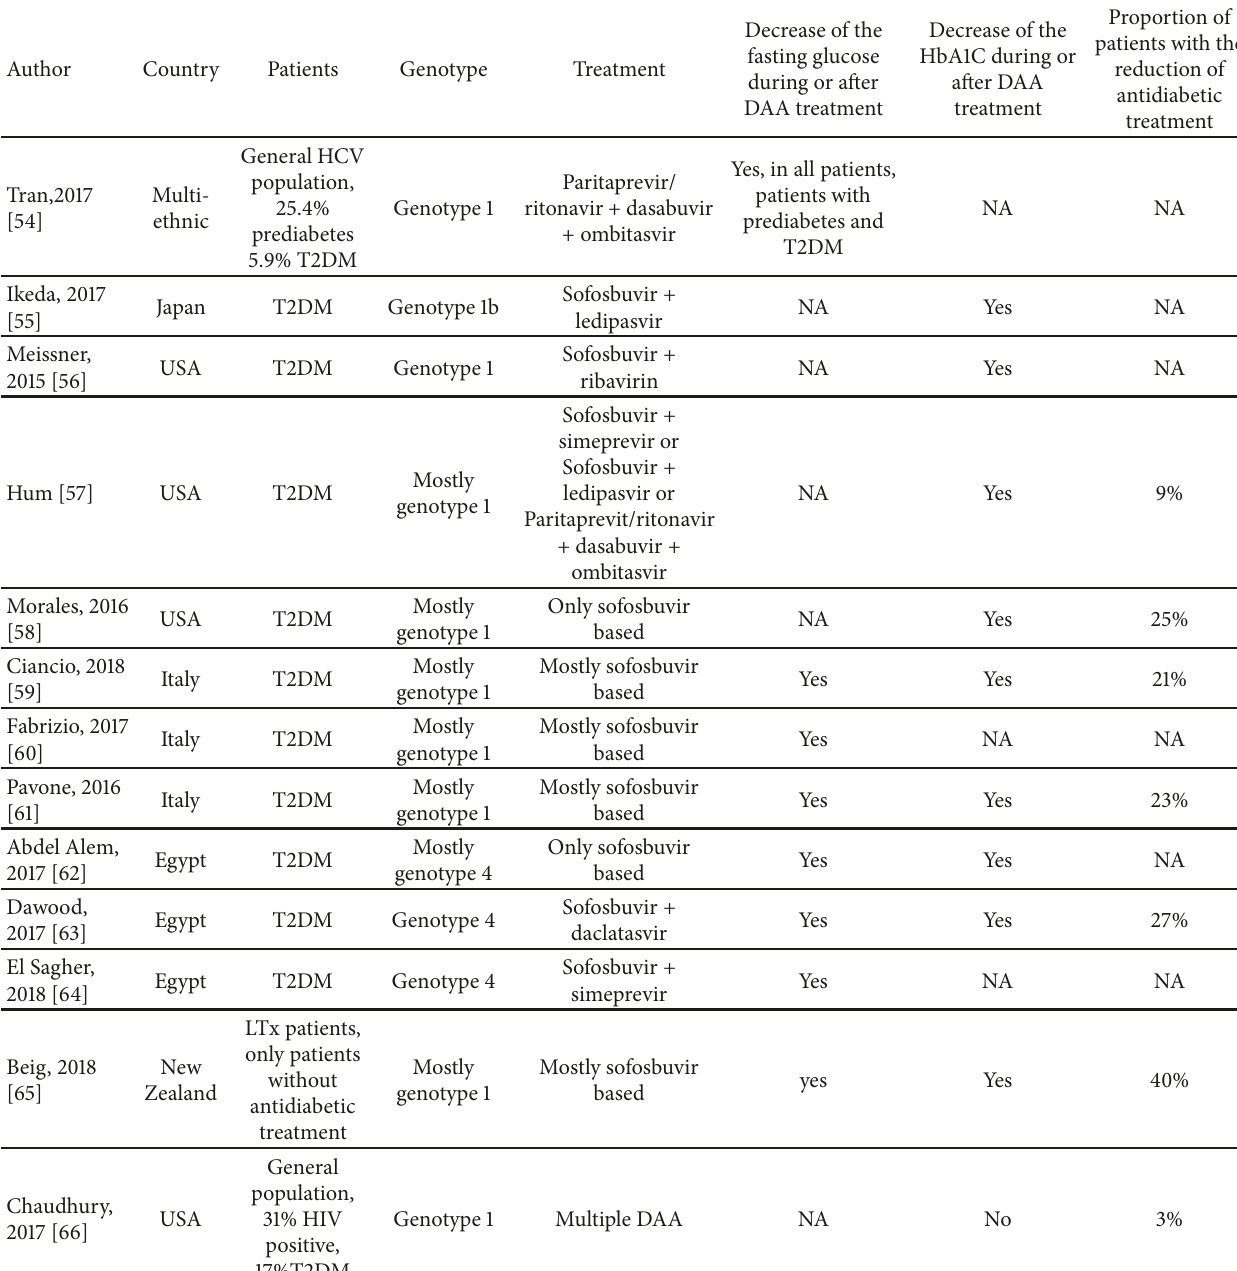
Table 1: Studies reporting the changes of fasting glucose, HbA1C, and antidiabetic treatment after DAA